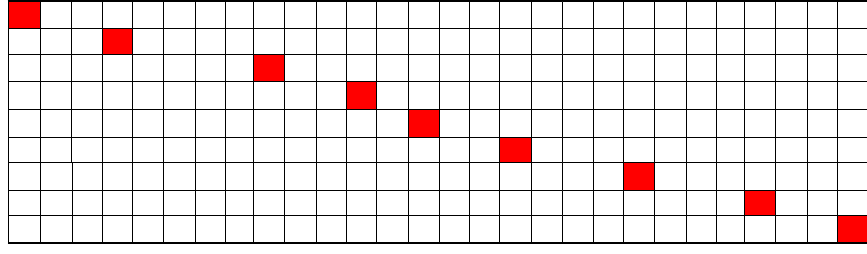
Figure 4. An example of the projection matrix